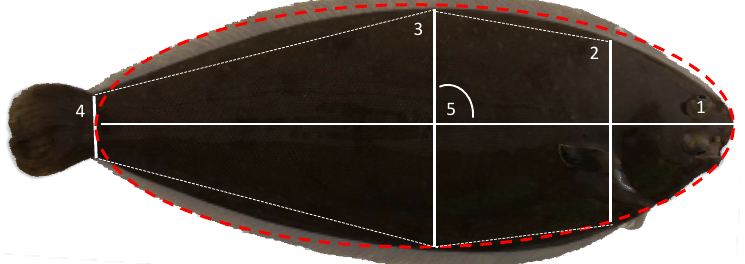
Figure 1. Shape measurements: 1: standard length (SL); 2: body height at the insertion of the pectoral fin (BHP); 3: body maximum height (BMH); 4: caudal peduncle height (CPH); and 5: ellipticity ((SL − BMH)/(SL + BMH)). A theoretical ellipse fitting the horizontal axis from the mouth tip to the peduncle center and the vertical axis to BMH is indicated by red dashed line.